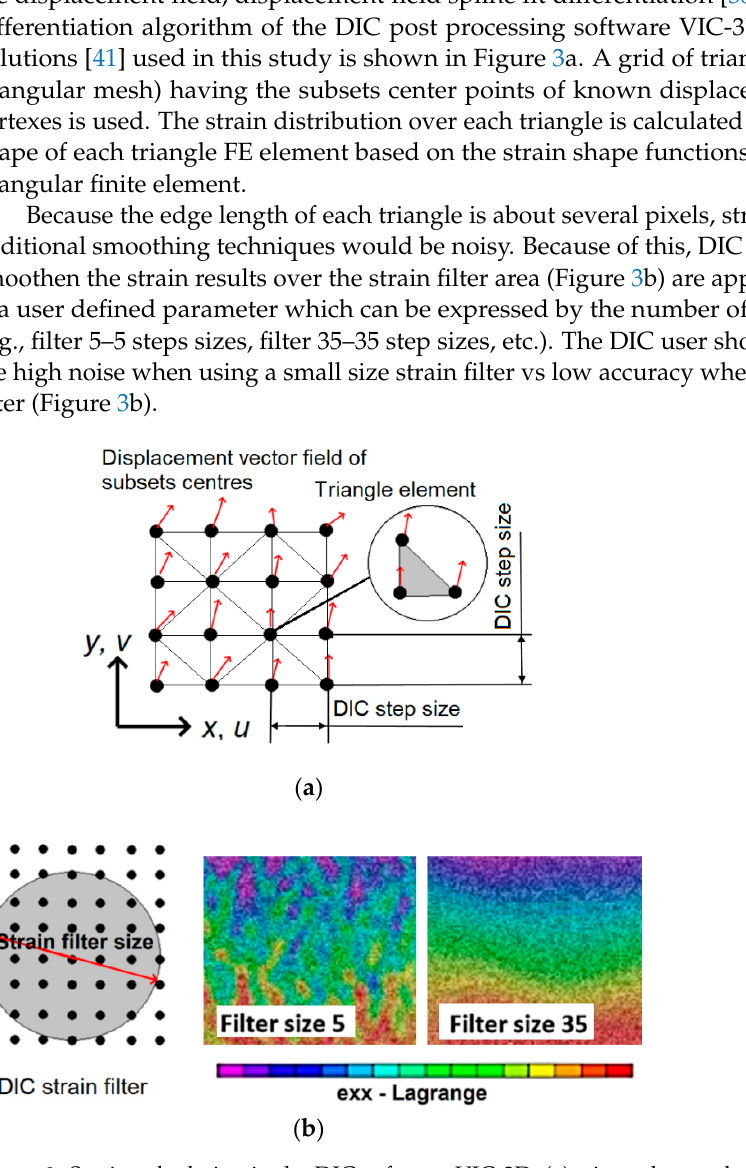
Figure 3. Strain calculation in the DIC software VIC-3D: ( a ) triangular mesh for strain calculation; ( b ) strain.